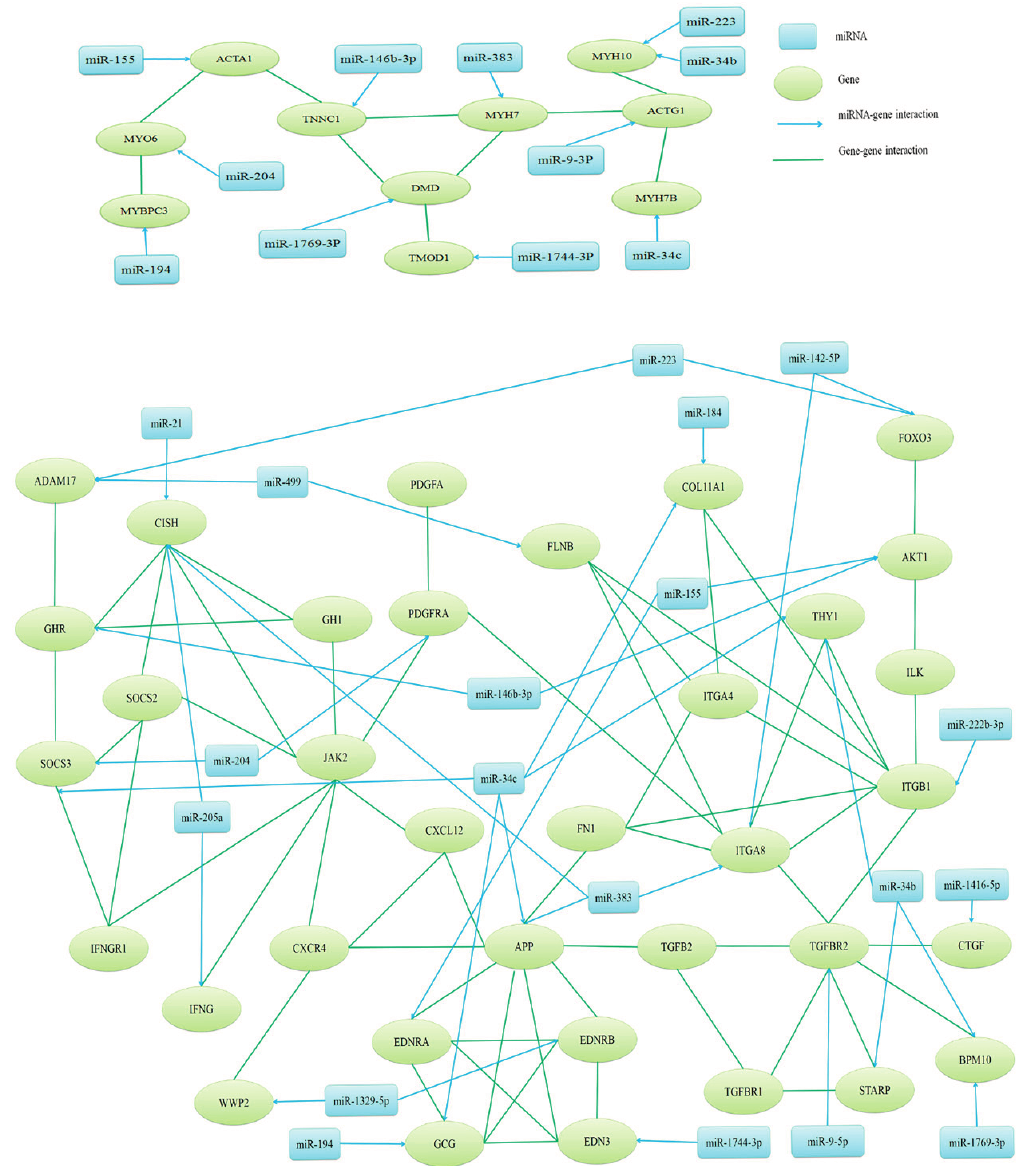
Figure 5. Interaction network of highly differentially expressed miRNAs and their potential targets. Candidate miRNA targets were obtained from growth related GO terms; and target–target pair interactions were searched using the STRING database. In the network; blue nodes denoted miRNAs and blue arrows denoted miRNA-target interaction; green nodes denoted targets and green lines denote target–target